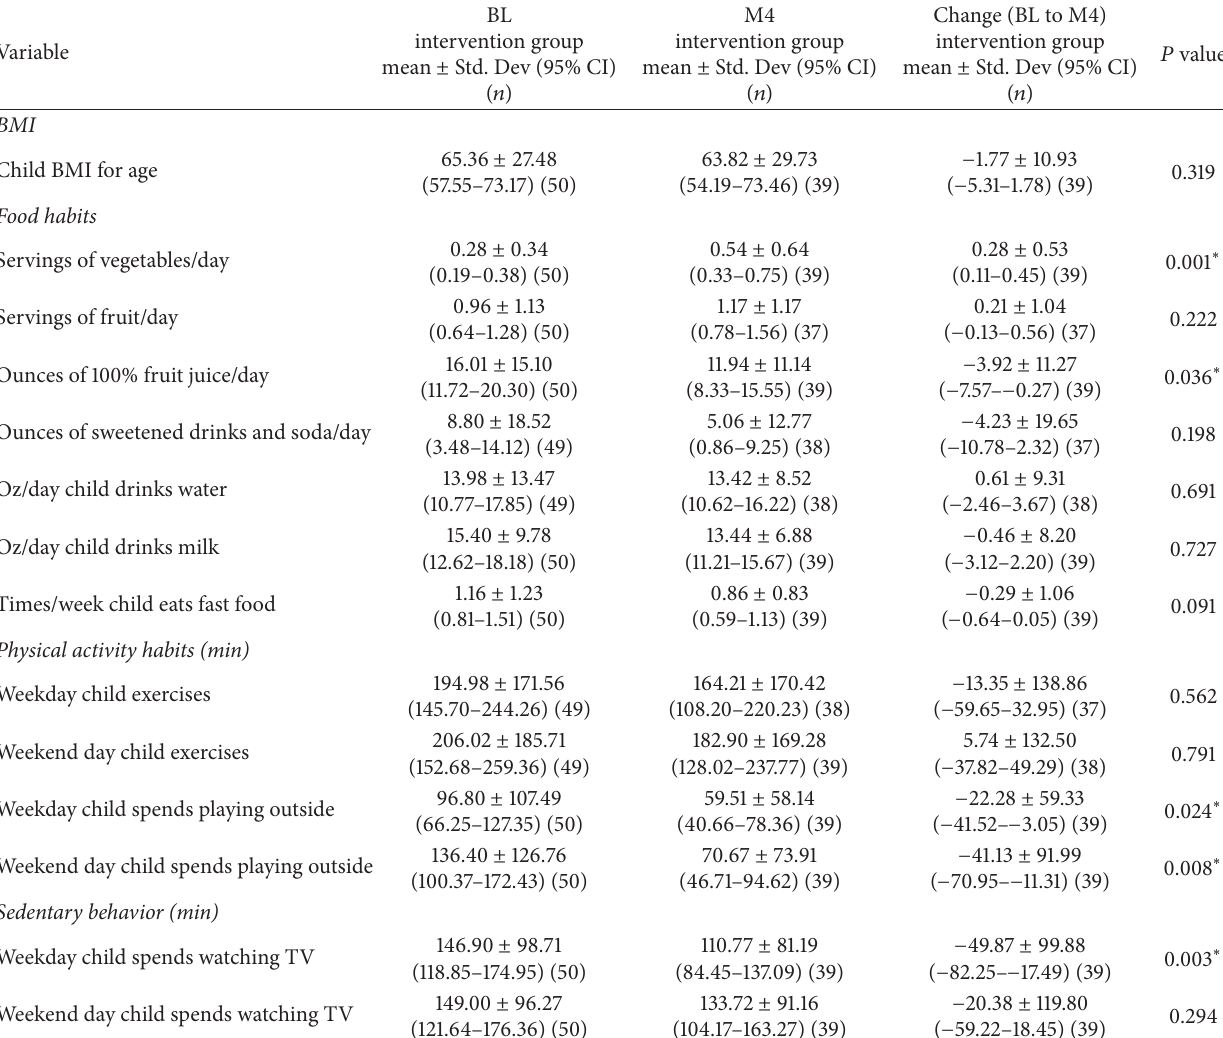
Table 3: Changes in child outcomes from baseline to month 4 and change scores for healthy homes, healthy families